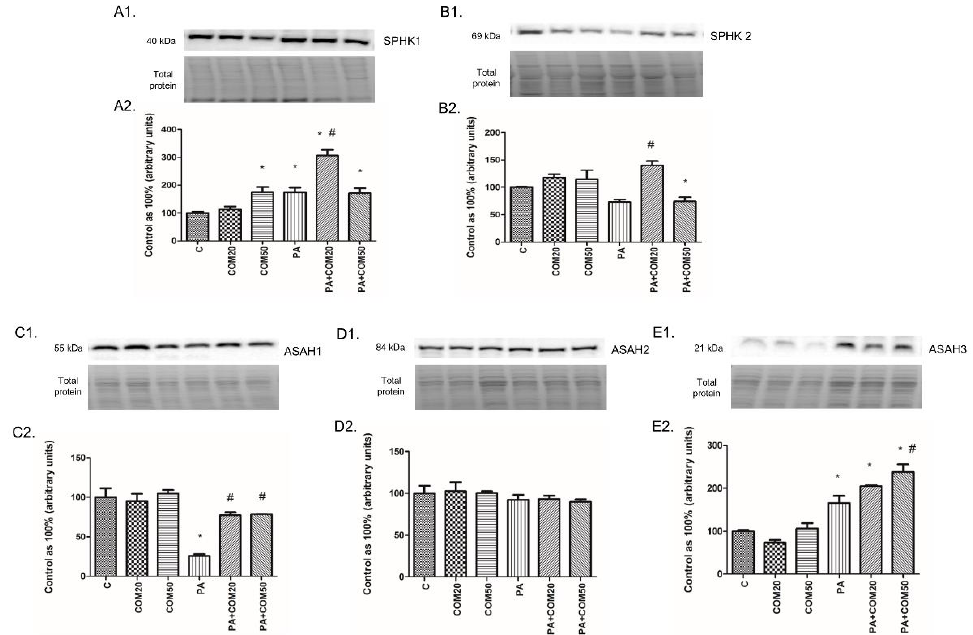
Figure 5. Representative Western blot membranes of evaluated proteins, i.e., SPHK1—sphingosine kinase 1 ( A1 ), SPHK2 – sphingosine kinase 2 ( B1 ), ASAH1—acid ceramidase ( C1 ), ASAH2—neutral ceramidase ( D1 ), ASAH3—alkaline ceramidase ( E1 ), and the corresponding images of total protein staining after membrane transfer used for normalization. The expression of enzymes involved in sphingolipid salvage pathway, i.e., SPHK1 ( A2 ), SPHK2 ( B2 ), ASAH1 ( C2 ), ASAH2 ( D2 ), and ASAH3 ( E2 ) in primary rat hepatocytes. The cells were incubated with presence or absence of PA (0.5 mM) or/and COM (20 or 50 μM), as it was described in Materials and Methods section. The protein expression was evaluated by the Western blot technique. The data are shown as the mean ± SD and are based on six independent determinations (n = 6); * p < 0.05 significant difference vs. control group; # p < 0.05 significant difference vs. palmitate group; C, control; COM20 or COM50, coumestrol 20 or 50 μM; PA, palmitic acid; PA + COM20 or PA + COM50, palmitic acid + coumestrol 20 or 50 μM.